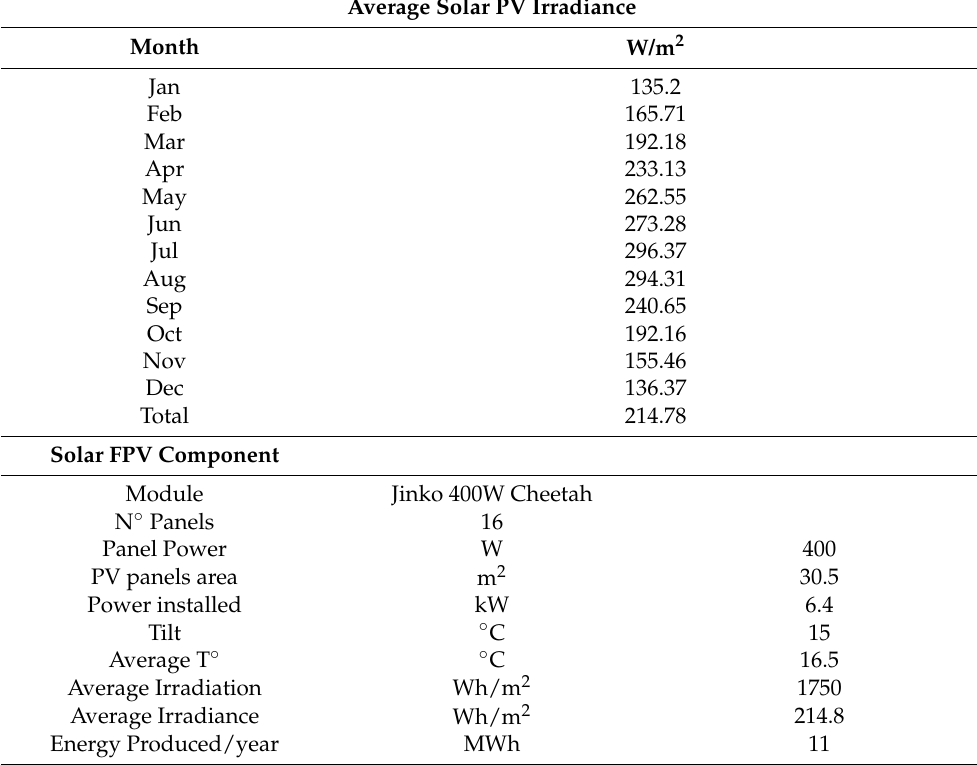
(Table 6, bottom), and it is also connected to the battery energy storage system. Table 6. Floating solar PV.